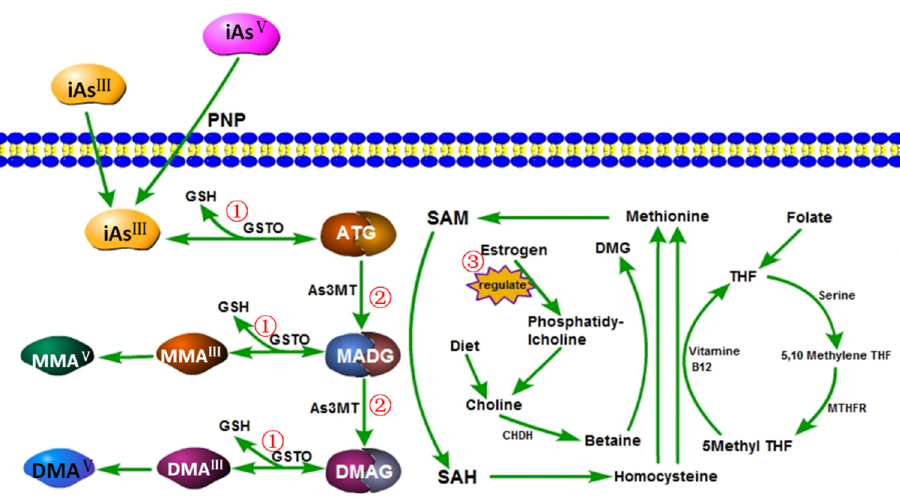
Metabolic pathways of arsenic methylation and one-carbon metabolism. iAs III , inorganic; iAs V , inorganic arsenate; MMA III , monomethylarsonous acid; MMA V , Monomethylarsonic acid; DMA III , dimethylarsinous; DMA V , dimethylarsinic acid; ATG, arsenic triglutathione; MADG, monomethylarsenic diglutathione; DMAG, dimethylarsinic glutathione; PNP, purine nucleoside phosphorylase; GSH, reduced glutathione; GSTO, glutathione S-transferase omega; SAM, S-adenosylmethionine; SAH, S-adenosylhomocysteine; CHDH, choline dehydrogenase; DMG, dimethylglycine; THF, tetrahydrofolate; MTHF, methylenetetrahydrofolate. 1 and 2: arsenic exposure might lead to insufficient metabolic-associated factors or enzymes, such as sadenosylmethionine (SMA) and glutathione (GSH); 3: estrogen can indirectly promote arsenic metabolism by up-regulating betaine formed by choline oxidation.